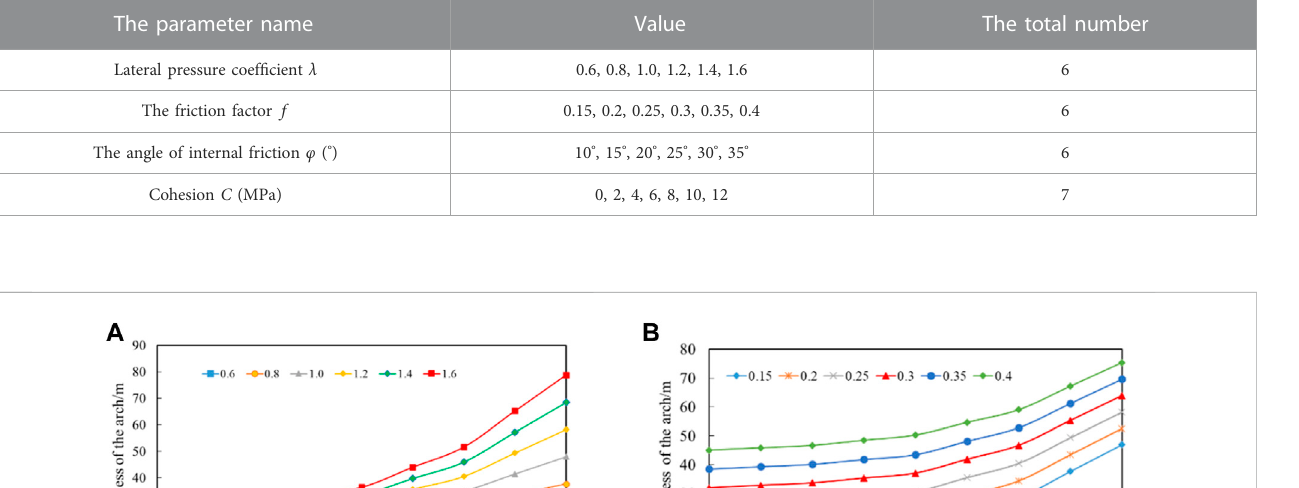
FIGURE 9 The variation law of the arch thickness of the SRPA (Surrounding rock pressure arch) with the rise-span ratio: (A) Lateral pressure coef fi cient, (B) Friction factor, (C) Angle of internal friction, (D) Cohesion.